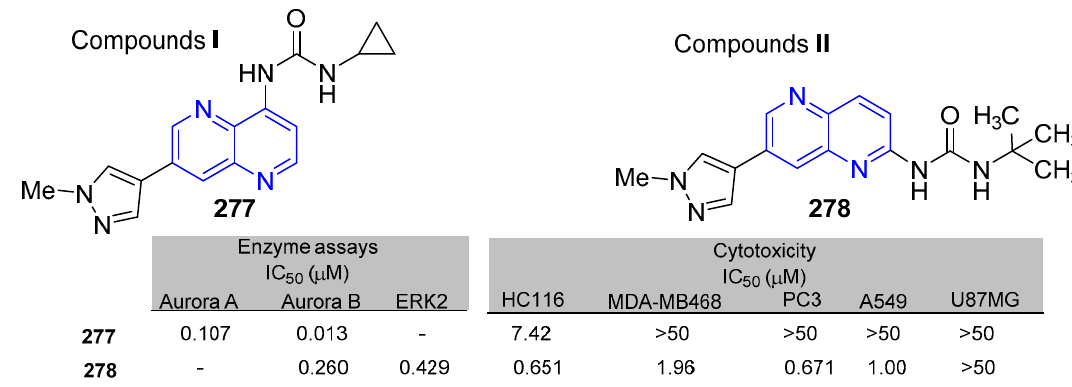
Figure 9. Biological activity on Aurora kinases A and B and cytotoxicity values.